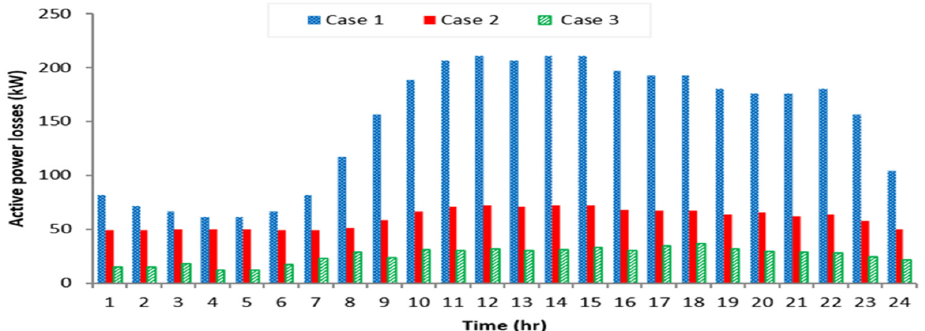
Figure 15. Active power losses at each hour for different cases for the first MG.